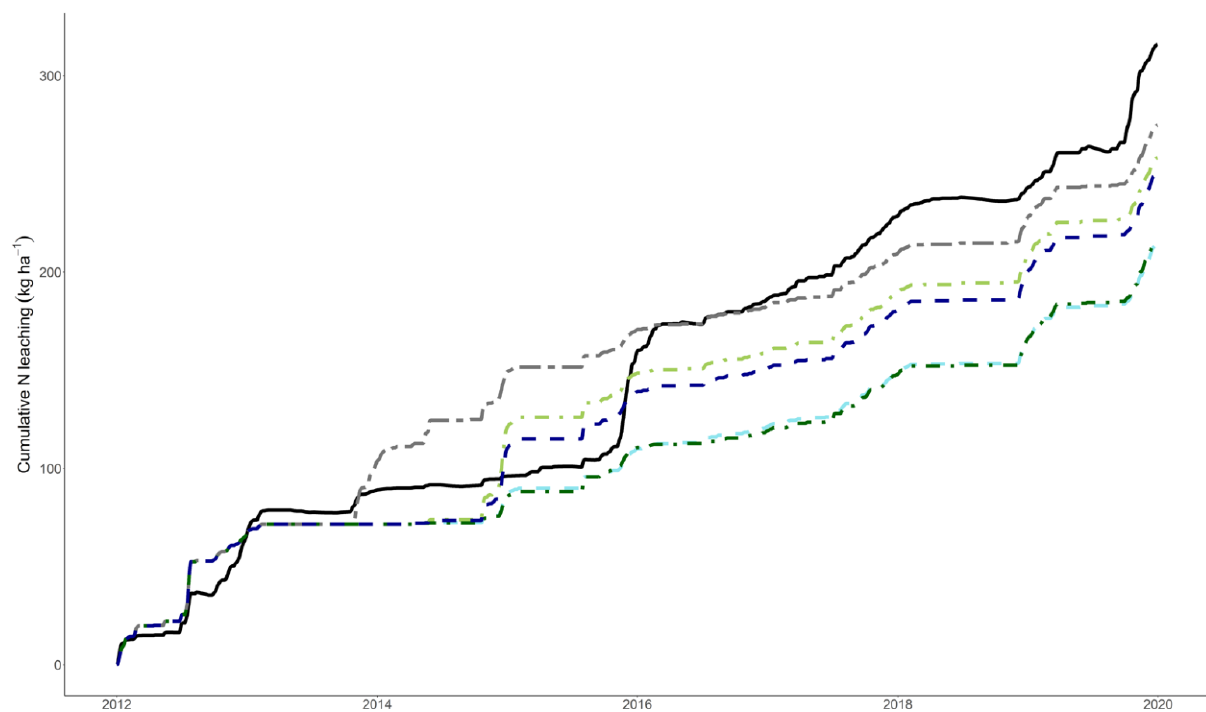
Figure 6. Cumulative nitrogen (N) leaching at experimental site 3, shown based on measured data (black line) and predicted in APSIM for the using different approaches including the approach without a ryegrass period (grey line), the generic approach accounting for aboveground residues (2000 kg ha −1 yr −1 ) (light blue line), the generic approach accounting for above- and belowground residues (6500 kg ha −1 yr −1 )(dark blue line), and the simple mineralization model (SMM) (6500 kg ha −1 yr −1 ) with immediate (light green line) and delayed mineralization (dark green line).